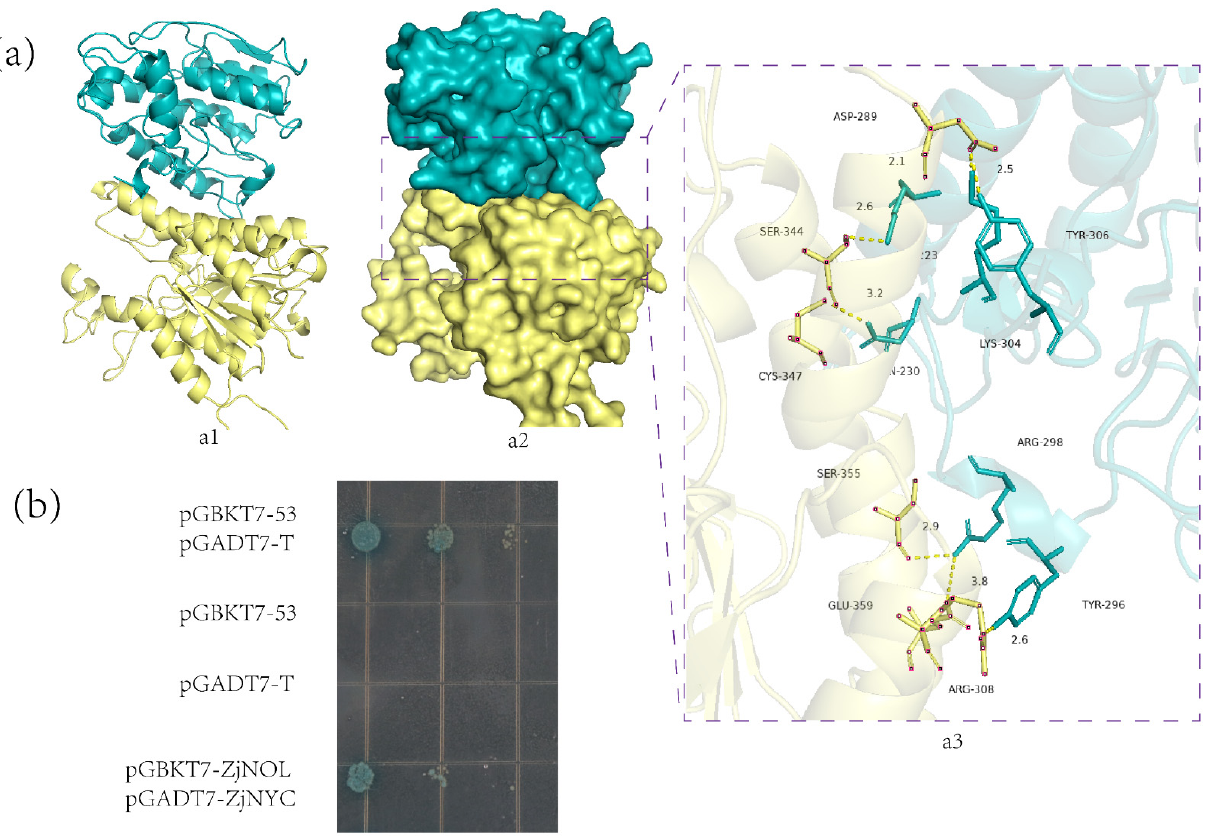
Figure 7. The interaction between ZjNOL and ZjNYC. ( a ) The binding mode of the complex ZjNYC with ZjNOL. ( a1 ), The backbone of protein was rendered in the tube and colored in blue (ZjNYC) and yellow (ZjNOL). ( a2 ), ZjNOL and ZjNYC proteins were rendered by the surface. ( a3 ), The detailed binding mode of ZjNOL with ZjNYC. Yellow dash represents hydrogen bond or salt bridge. ( b ) Interaction between ZjNOL and ZjNYC. By 10-fold repeated dilutions, yeast cells were identified on increasing stringency QDO/X/A agar plates. Positive clones were blue, whereas negative clones were white or missing. The negative control was pGBKT7-53 or pGADT7-T, while the positive control was pGBKT7-53 and pGADT7-T co-transformed. ( c ) The interaction between ZjNOL and ZjNYC in living cells showed by BiFC. ( c1 – c4 ), YCE-ZjNOL and YNE-ZjNYC fluorescent detection. ( c5 – c8 ), YCE-ZjNOL and YNE fluorescent detection. ( c9 – c12 ), YNE-ZjNYC and YCE fluorescent de- tection. ( c1 , c5 , c9 ), Bright light; ( c2 , c6 , c10 ), chlorophyll autofluorescence; ( c3 , c7 , c11 ), YFP fluorescence; ( c4 , c8 , c12 ), merged signal. Negative control was YCE-ZjNOL co-expression with YNE or YNE-ZjNYC co-expression with YCE.